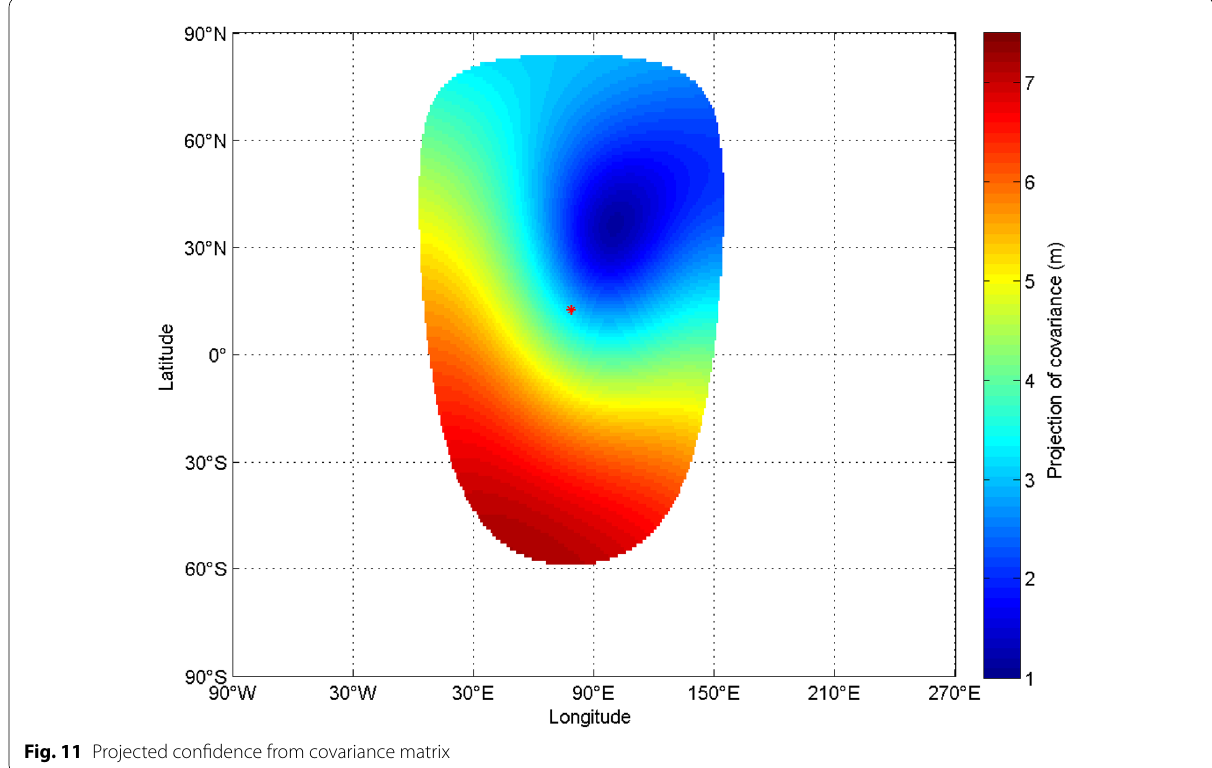
Fig. 11 Projected confidence from covariance matrix